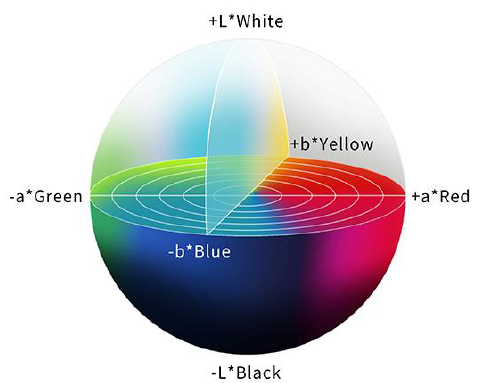
Figure 3. The color space according to the International Commission on Illumination 1976 definition (L*a*b*). This color space is designed to approximate human perceptions. The Euclidean distance between two points is proportional to the difference in perception of the two corresponding colors.